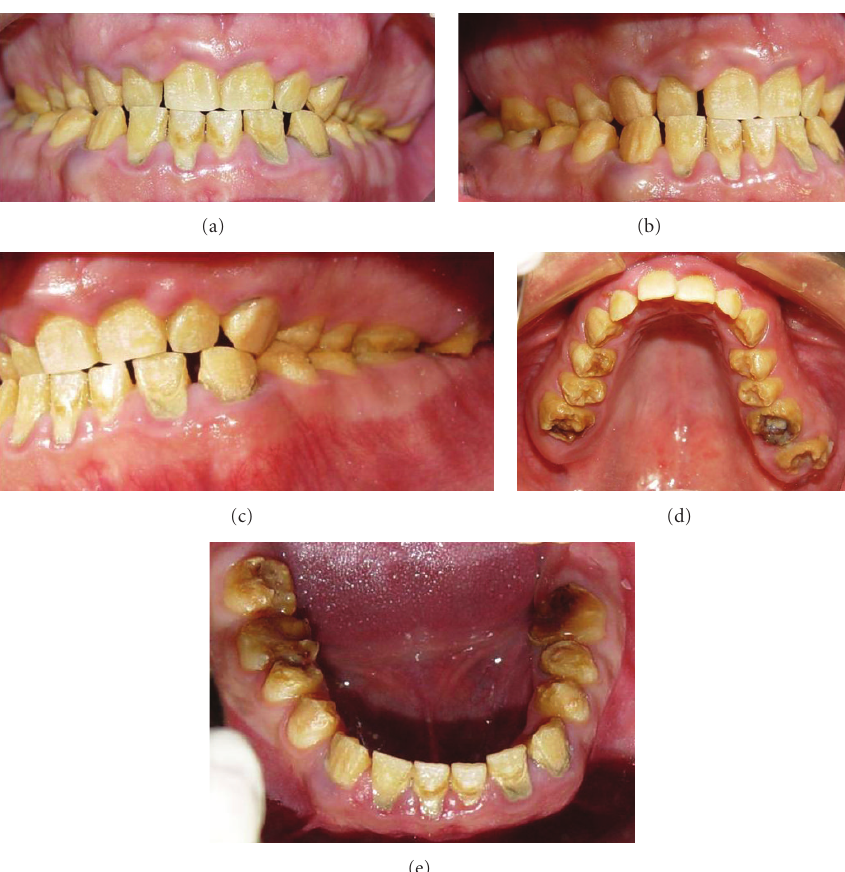
Figure 1: Pretreatment intraoral view: (a) frontal view; (b) right lateral view; (c) left lateral view; (d) maxillary occlusal view; (e) mandibular occlusal view.